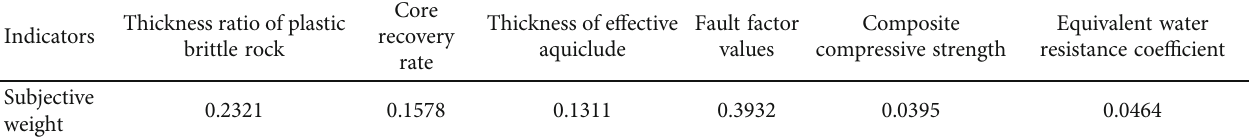
Table 7: Subjective weight determined by AHP.